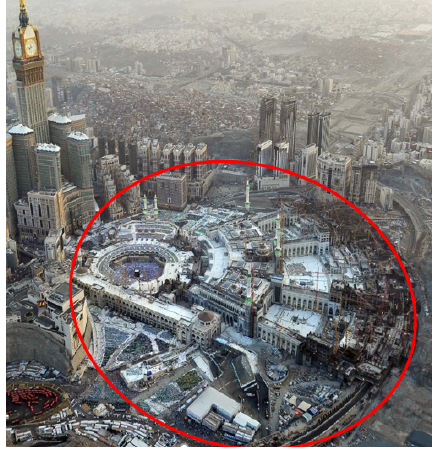
Figure 10. Circular coverage region with r = 1125